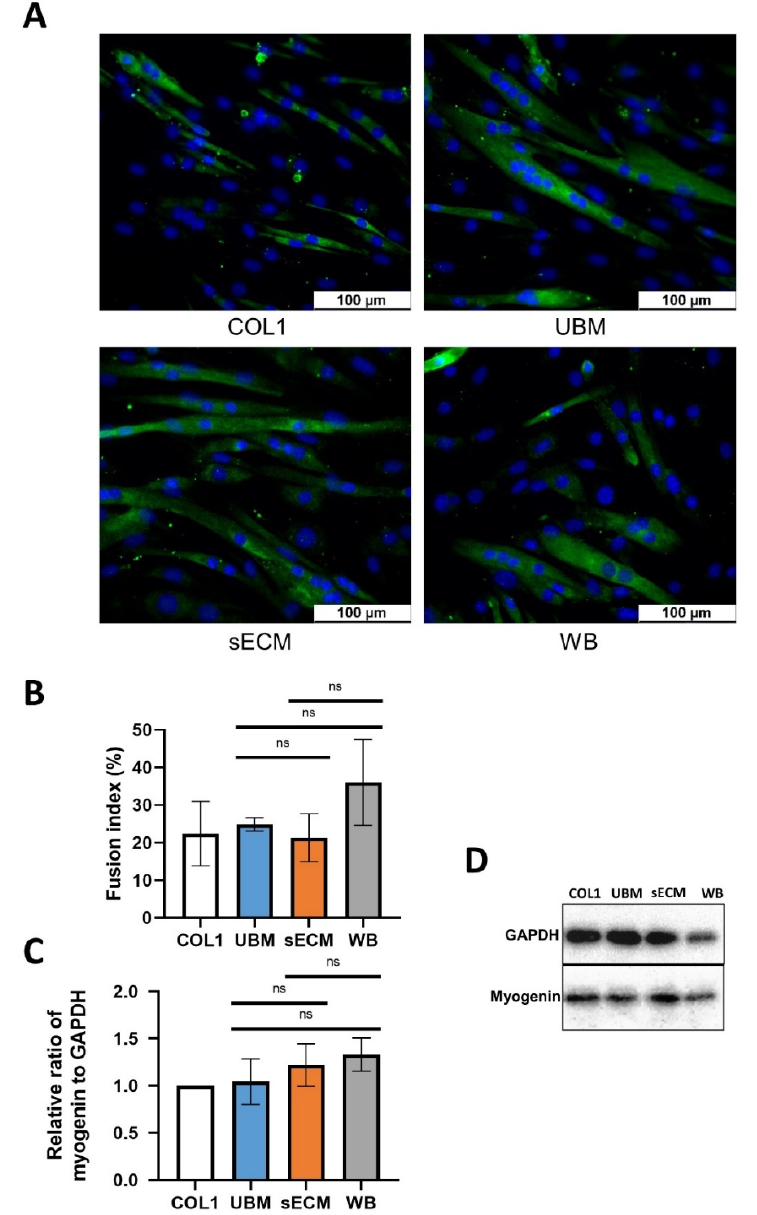
Figure 7. C2C12 differentiation after 3 days in MDM medium. ( A ) Representative immunostaining of C2C12 cells with MyHC antibody (green) and nuclei (blue) (scale bar 100 μ m). ( B ) Fusion index of C2C12 on different coated surface ( n = 3). Relative expression level myogenin ( n = 4) ( C ) and representative immunoblotting of myogenin ( D ) in Western blot study.